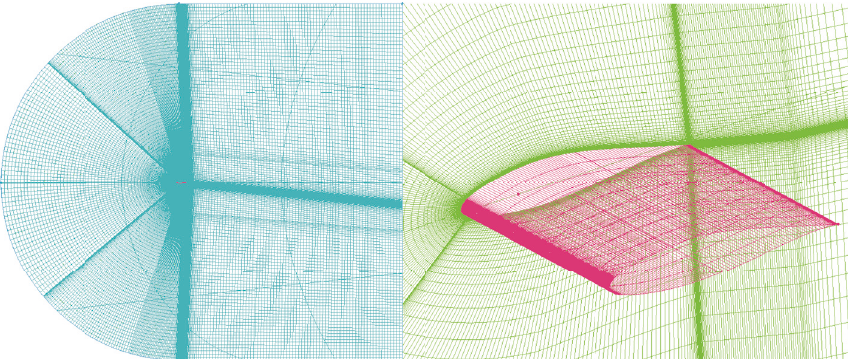
Figure 2: 2D and 3D airfoil mesh of